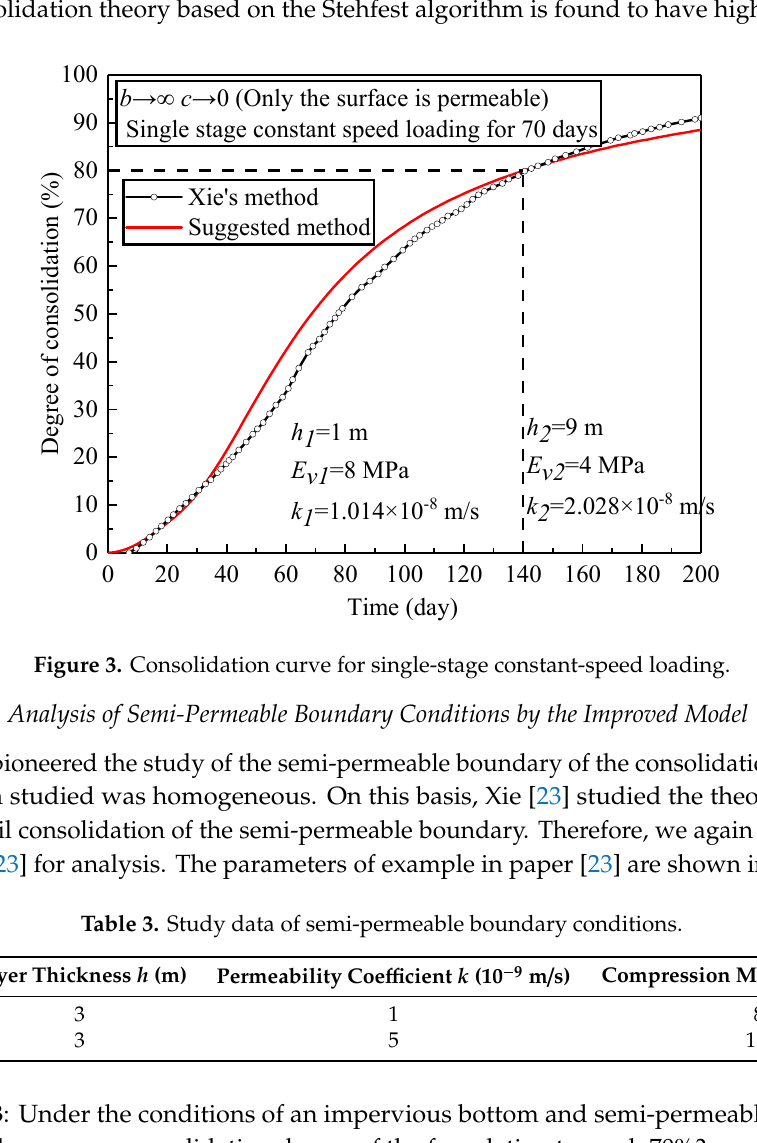
Figure 2. Consolidation curve for the instantaneous loading.